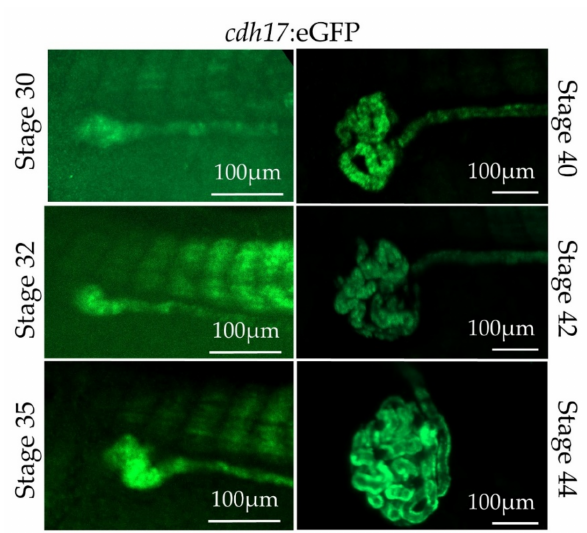
Figure 5. Live imaging of kidney development using cdh17 :eGFP reporter line. Kidney development within a transgenic embryo was visualized by GFP expression from stages 30 to